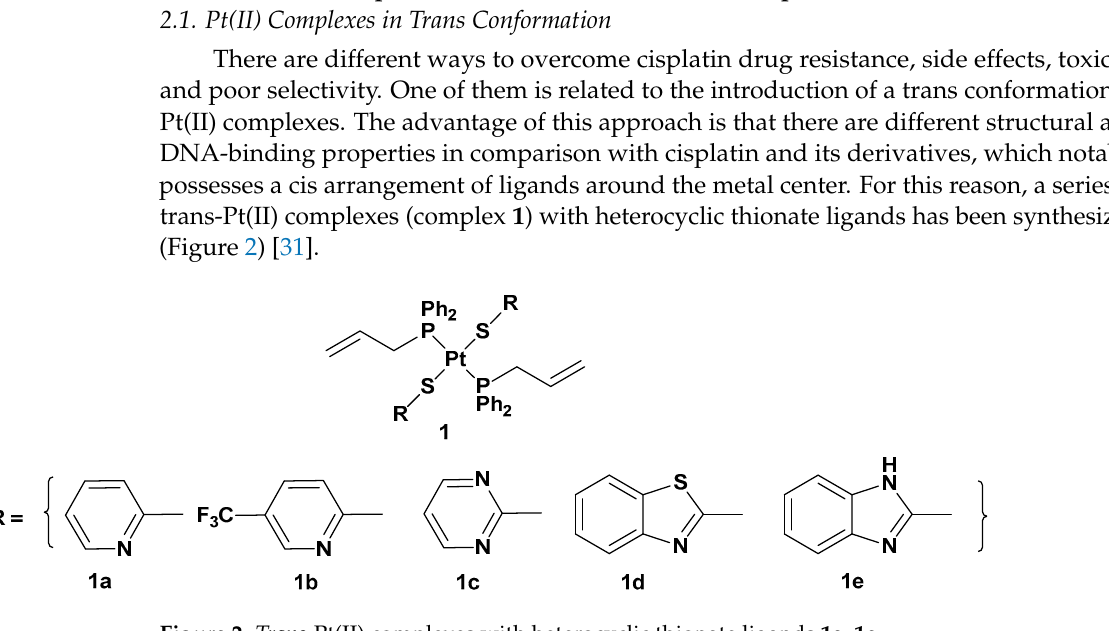
Figure 2. Trans -Pt(II) complexes with heterocyclic thionate ligands 1a - 1e .